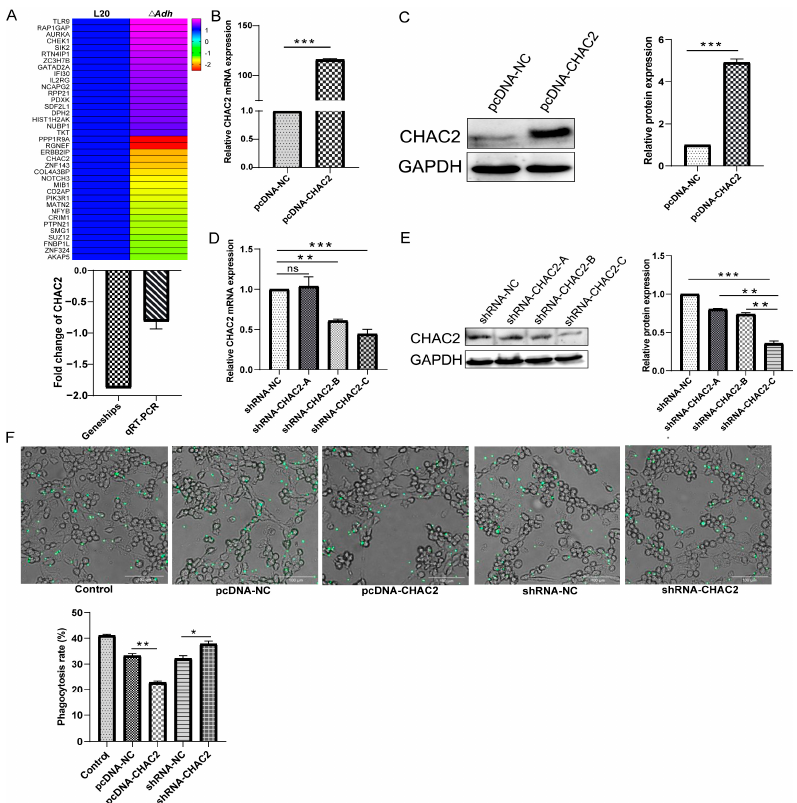
Figure 2. CHAC2 overexpression plasmid and shRNA plasmid were constructed to analyze the phagocytic capacity of PAM. ( A ) Heatmap of differential gene expression profiles in piglet lungs induced by Adh . ( B , C ) Detection of ( B ) mRNA and ( C ) protein expression level of pcDNA-CHAC2. ( D , E ) Detection of ( D ) mRNA and ( E ) protein expression level of shRNA-CHAC2. ( F ) Phagocytic fluorescent microspheres were used to evaluate the impact of CHAC2 on PAM phagocytosis. t -test and One-way ANOVA. NS p > 0.05, * p < 0.05, ** p < 0.01, and *** p <